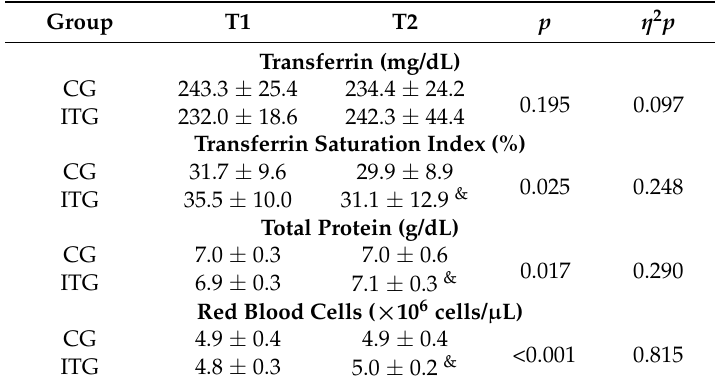
Table 3. Hematological parameters and total protein in the control group (CG) and iron treatment group (ITG) at baseline (T1) and after 3 weeks (T2). Group T1 T2 p η 2 p Transferrin (mg/dL) CG 243.3 ± 25.4